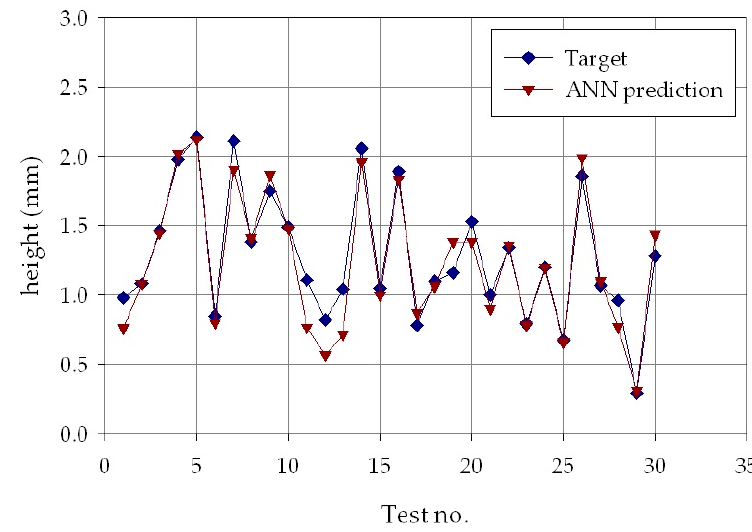
Figure 11. Experimental average (blue marks) and ANN estimated (orange marks) deposit height, h , for each of the p = 30 experimental conditions.